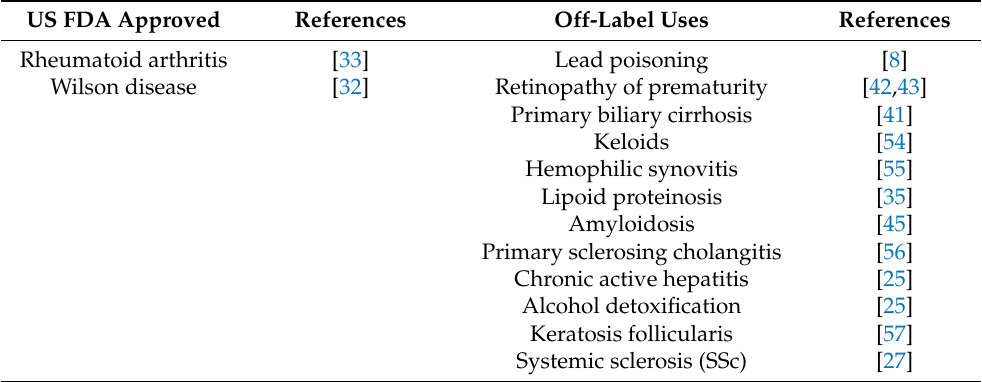
Table 1. Penicillamine: therapeutic